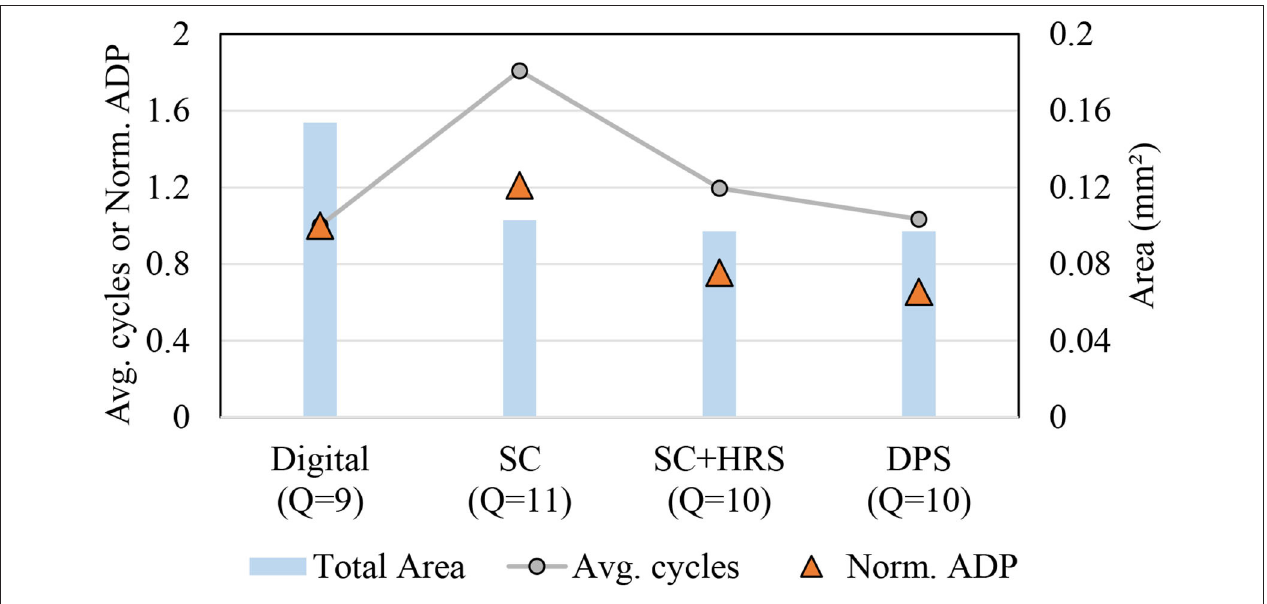
FIGURE 10 | Comparison with previous SC-CNN on AlexNet.